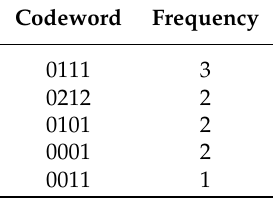
Table 7. Codeword frequency in Level 3 of the Lmax bitmap in the k 2 -raster structure in Figure